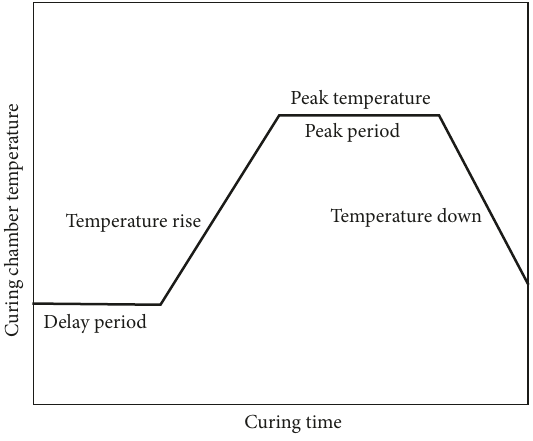
Figure 2: High-temperature curing